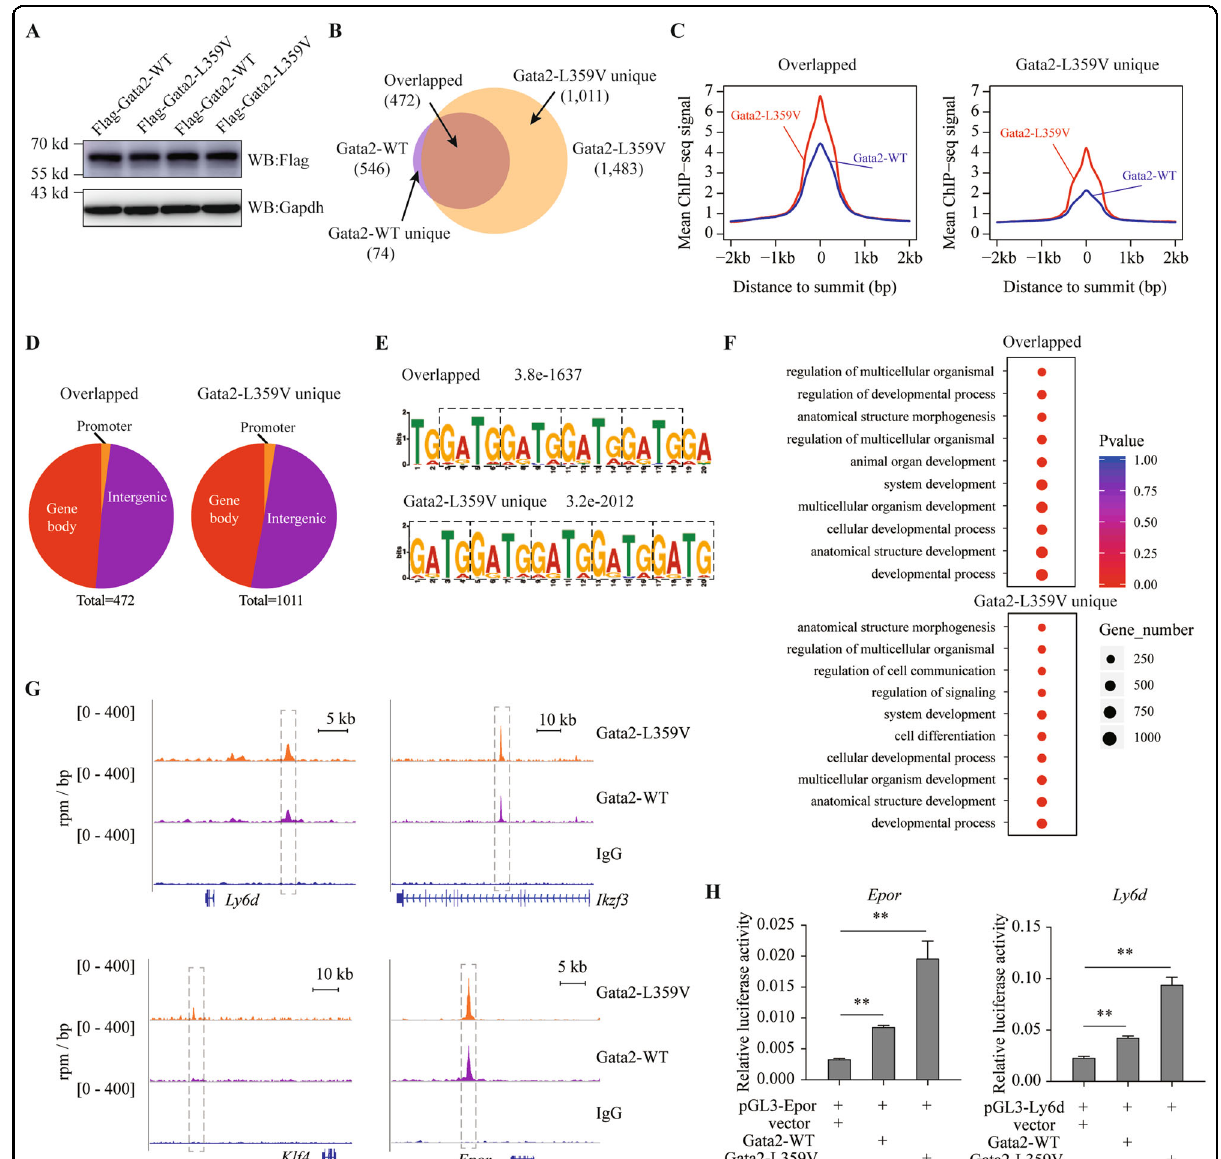
Fig. 5 Enhancement of DNA binding and transcriptional regulation on Gata2 targets by Gata2 -L359V mutation. A Validation of the enforced expression of Gata2-WT or Gata2-L359V in 32D cells using an antibody that can recognize different species of Gata2 protein, including WT and Gata2- L359V mutant forms. The Flag-Gata2-WT or Flag-Gata2-L359V plasmid were transfected into the 32D cells. Antibodies against Flag or Gaphd were used for western blot analysis. B Overlap analysis between Gata2-WT- and Gata2-L359V-bound regions. The Gata2-WT uniquely bound (Gata2-WT unique), Gata2-L359V uniquely bound (Gata2-L359V unique), and Gata2-WT/Gata2-L359V co-bound (Overlapped) targets were identi fi ed. C ChIP-seq binding signal of Gata2-WT and Gata2-L359V on the overlapped and the Gata2-L359V unique regions. D Genomic distribution patterns of the overlapped and the Gata2-L359V unique regions. E De novo motif analysis of the overlapped and the Gata2-L359V unique regions. F GO analysis of genes in the overlapped regions or Gata2-L359V unique bound regions. G Genome browser visualization of Gata2-WT and Gata2-L359V binding on the representative targets. H Analysis of Gata2-WT and Gata2-L359V on the enhancer activity of Ly6d and Epor ( p < 0.01, Student ’ s t